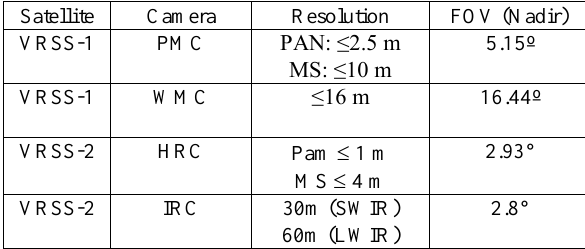
Table 1. VRSS-1and VRSS-2 Cameras